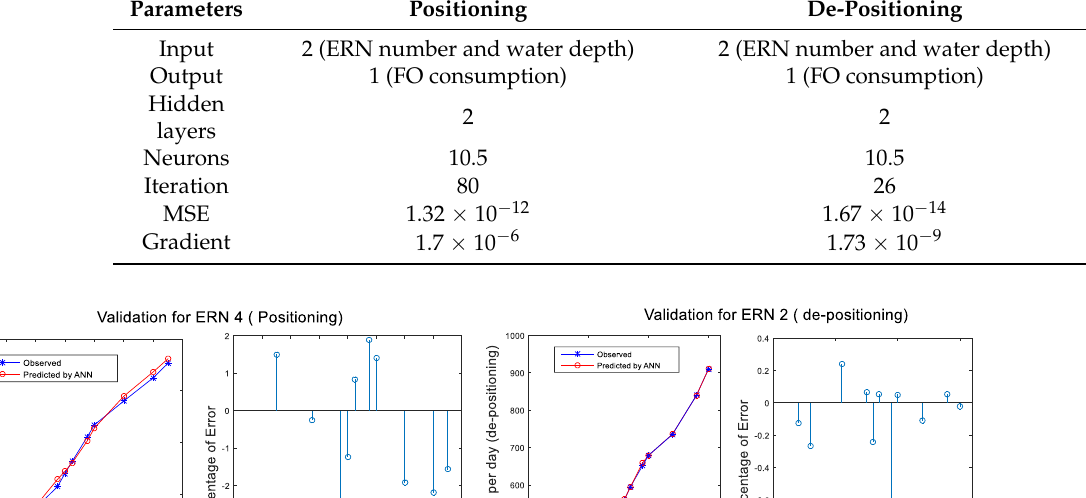
Table 8. Parameters of the trained ANNs for FO consumption prediction in SM system. Parameters